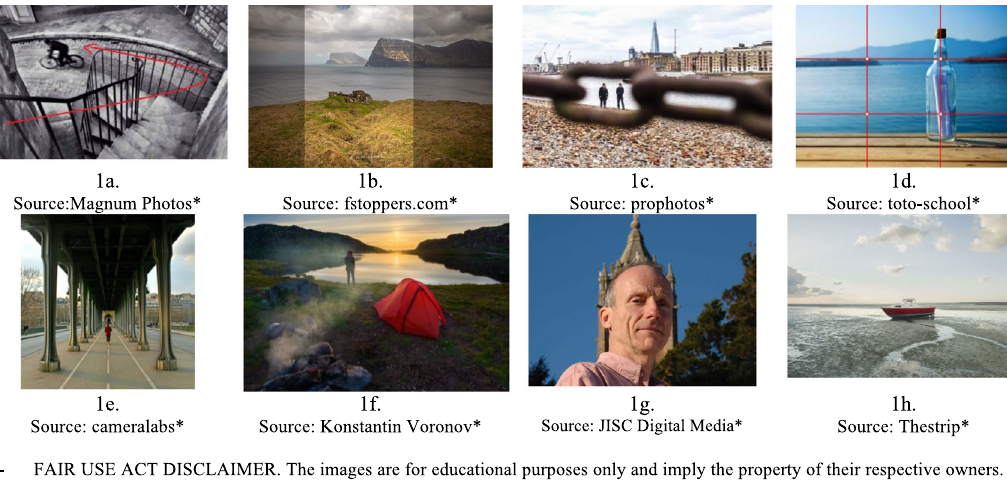
Fig. 1 Basic rules of photo aesthetics and composition. Directional lines ( a ); image orientation and colours ( b ); framing ( c ); rule of thirds ( d ); image symmetry ( e ); image depth and angle ( f ); objects planning/details ( g ); light/time of day ( h